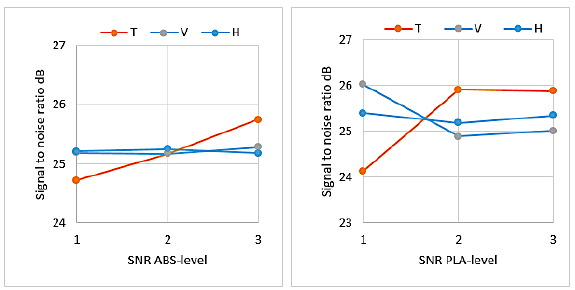
Figure 7. signal-to-noise-ratio analysis on